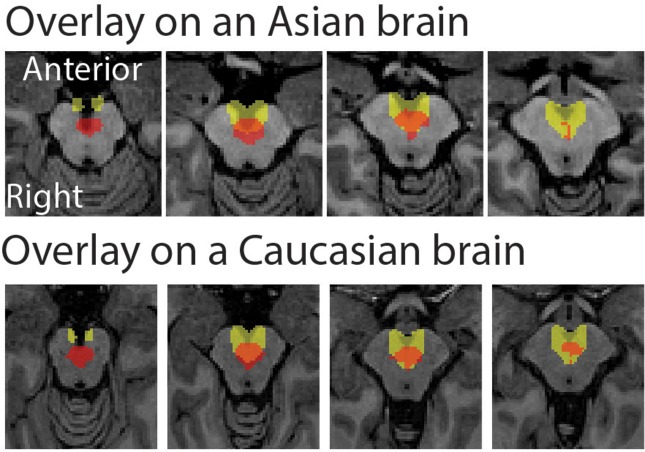
Morphological differences between Asian and published VTA templates. Asian (red) and published (yellow) templates of VTA transferred to an individual space were overlay on an Asian sample from dataset 2 (the upper raw), and that of VTA templates were overlay on a Caucasian template (the bottom row).